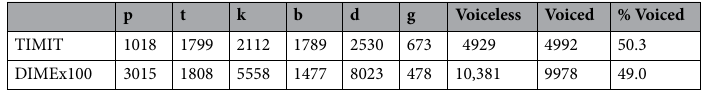
Table 1. Counts of sequences beginning with each stop for each